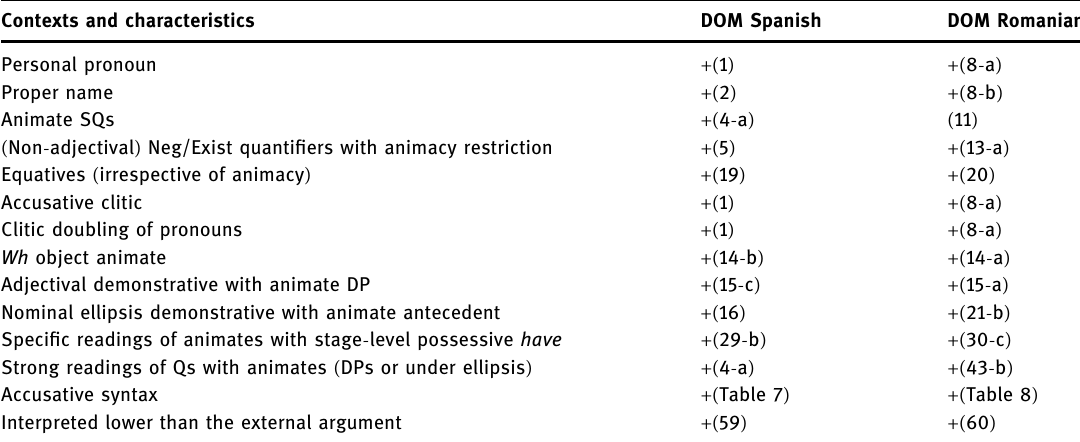
Table 6: DOM similarities – standard Spanish and Romanian